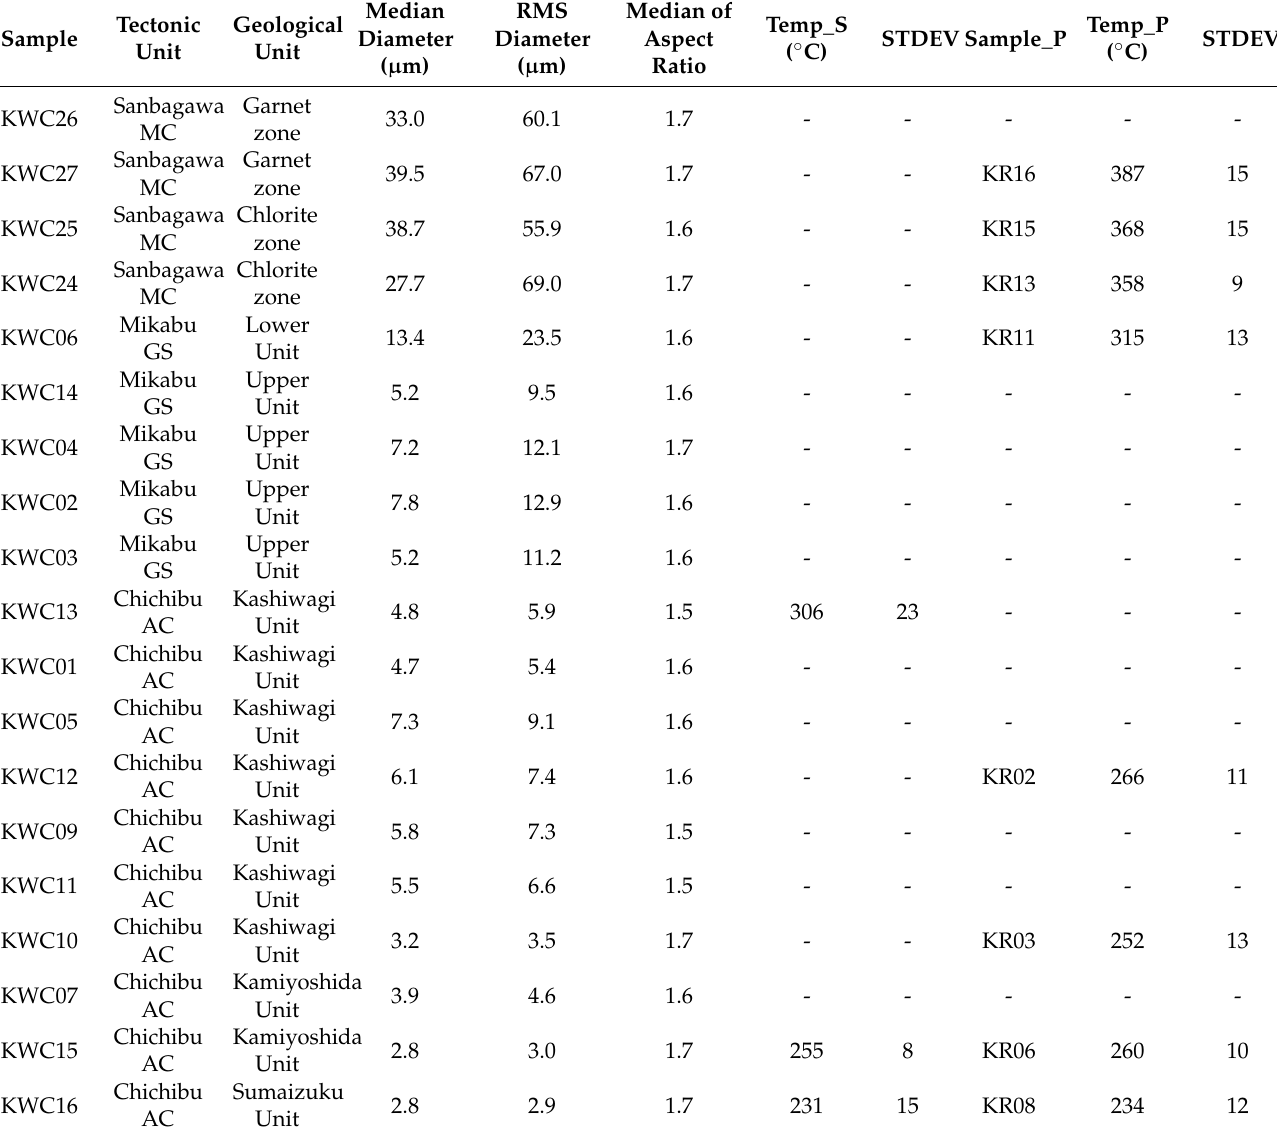
Table 2. Summary of the EBSD analyses of siliceous rock samples from the study